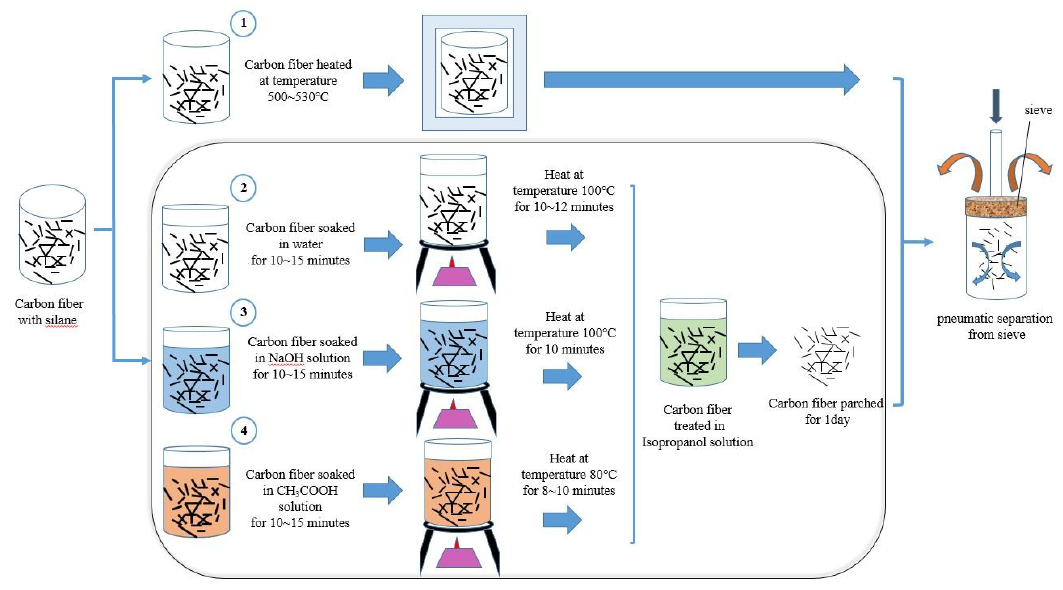
Figure 4. Illustration of silane removal from short carbon fiber surfaces using different approaches.